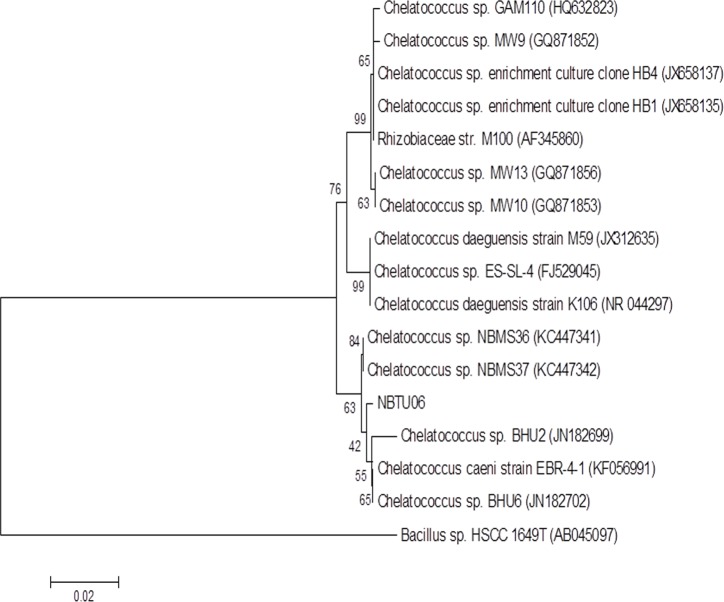
Phylogenetic relationships of isolated NBTU-06 and other closely related Chelatococcus species based on 16S rRNA sequencing.The tree was generated using the neighbor-joining method and the sequence from Bacillus sp. HSCC 1649 T (Accession no. AB045097) was considered as out-group. The data set was resampled 1,000 times by using the bootstrap option, and percentage values are given at the nodes.